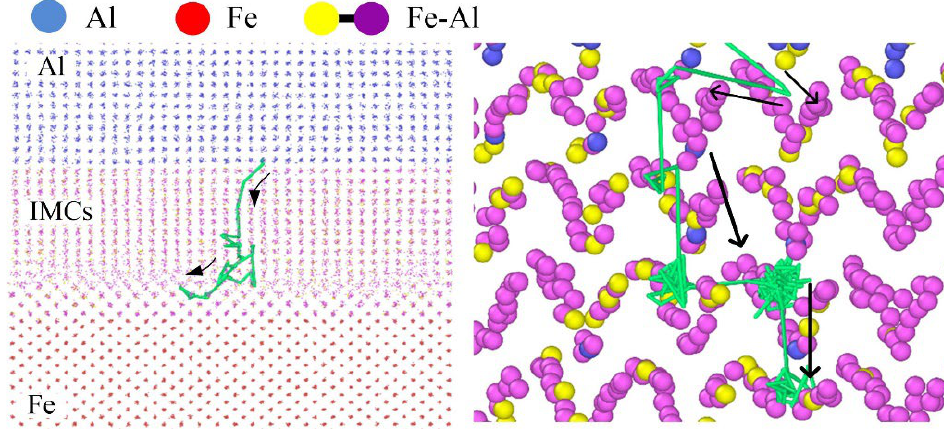
Figure 8. Al atom diffusion path across the interface. As shown in Figure 9, the Al atoms immigrate might in three paths: nearest neighbor jumping, second nearest neighbor jumping, and gap jumping. The first two belong to the vacancy diffusion mechanism. The Al atoms diffuse to the Fe side, occupying the lattice of Al atoms, and then the Fe atoms leap to the adjacent vacancies. The third mechanism is the diffusion of Al atoms to the Fe side, where they become octahedral gap atoms and then jump to another position in the octahedral gap.